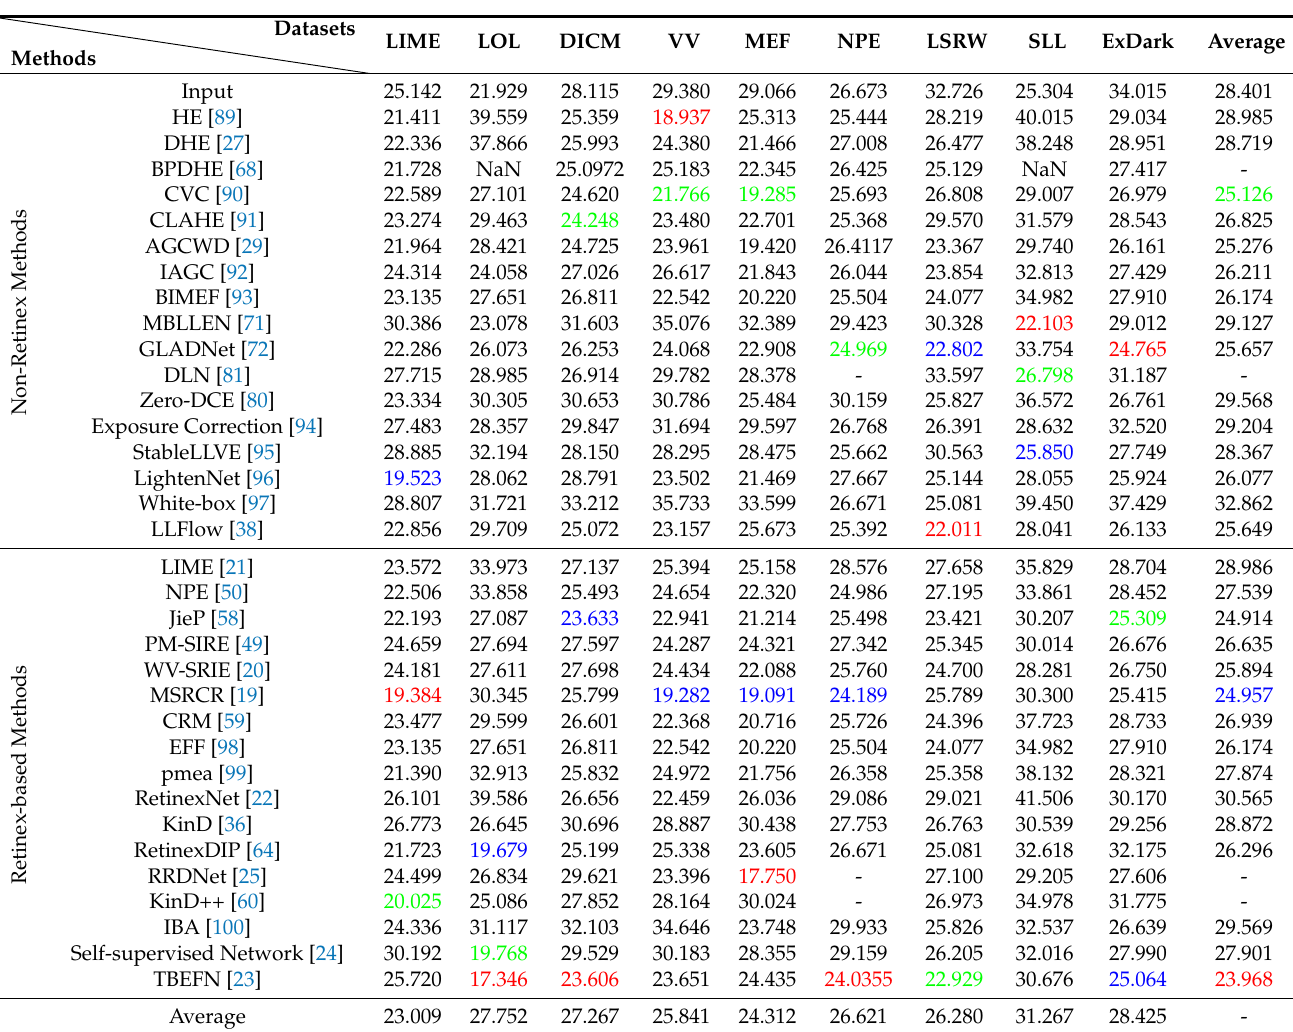
Table 4. Quantitative comparison of enhancement algorithms on nine test datasets using BRISQUE metric. A lower value of the BRISQUE metric indicates better performance. The first, second, and third best scores are highlighted with red, blue, and green colors,